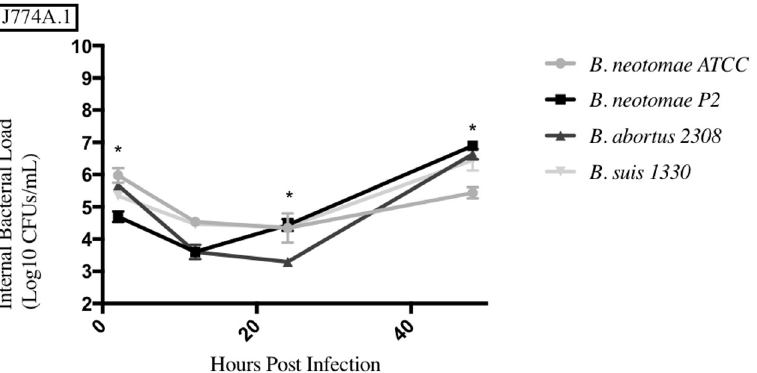
Fig 9. Intracellular survival of Brucella species in the murine macrophage cell line (J774A.1). Intracellular Brucella spp. CFUs were determined over 48hrs in J774A.1 as described. Error bars represent the standard error of the triplicates from a two seperate experiments. � represents when intracellular CFUs from more than one species tested statistically differs from BN with any p value lower than 0.05.